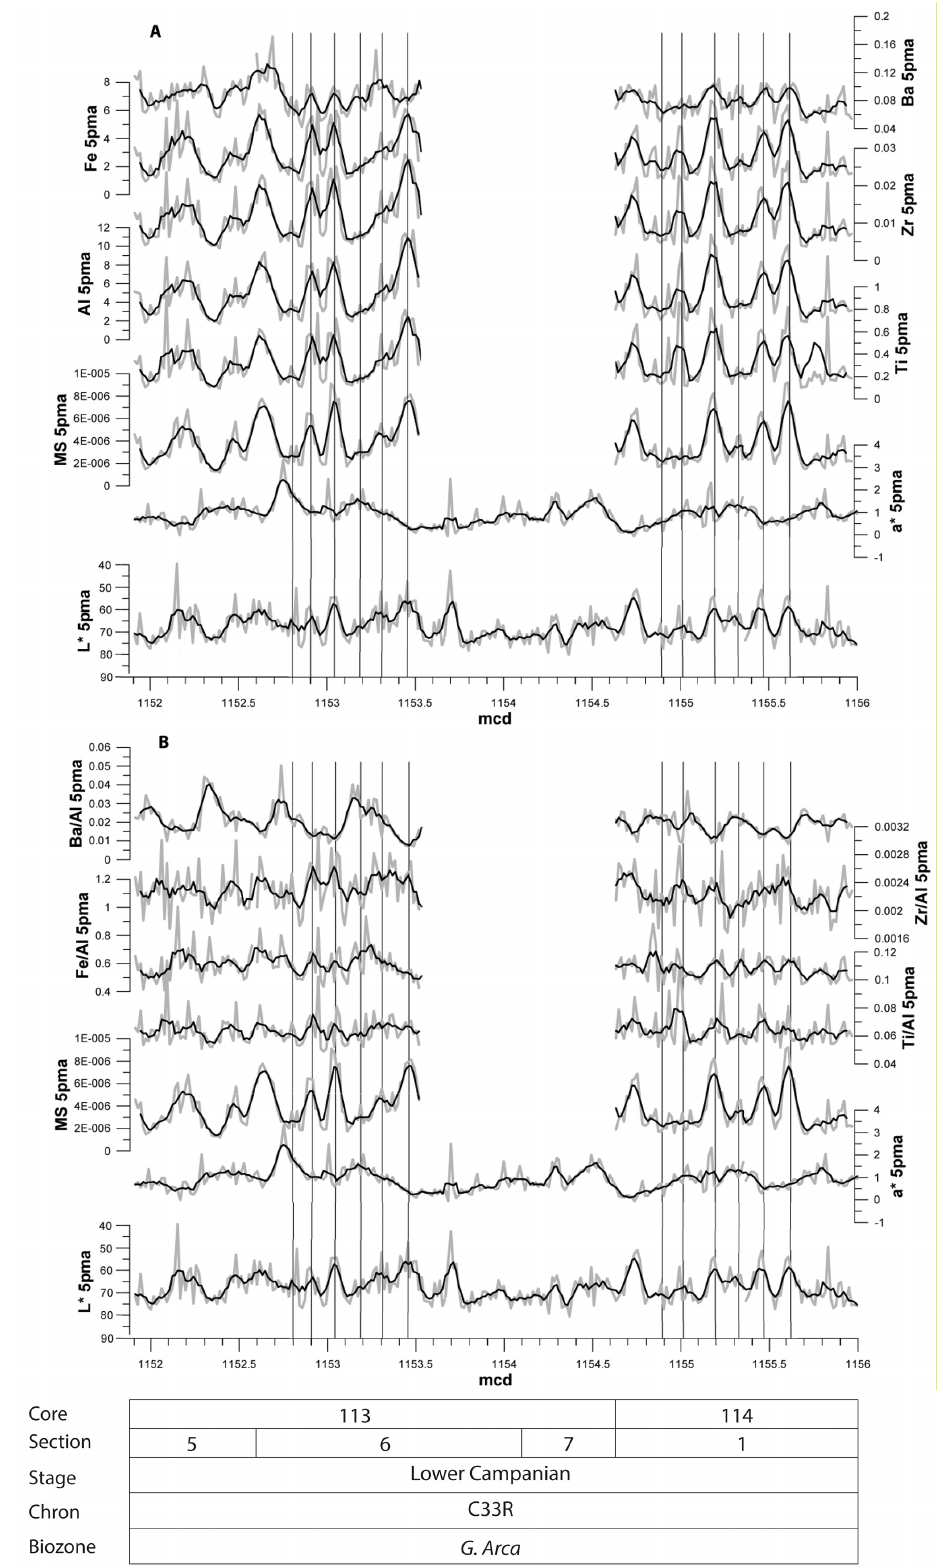
Figure 2. L ∗ , a ∗ and MS short data with Ti, Fe, Zr and Ba abundances (A) and abundances divided by Al (B) plotted against depth. The panel below shows the stratigraphic position of the studied interval and which core sections were